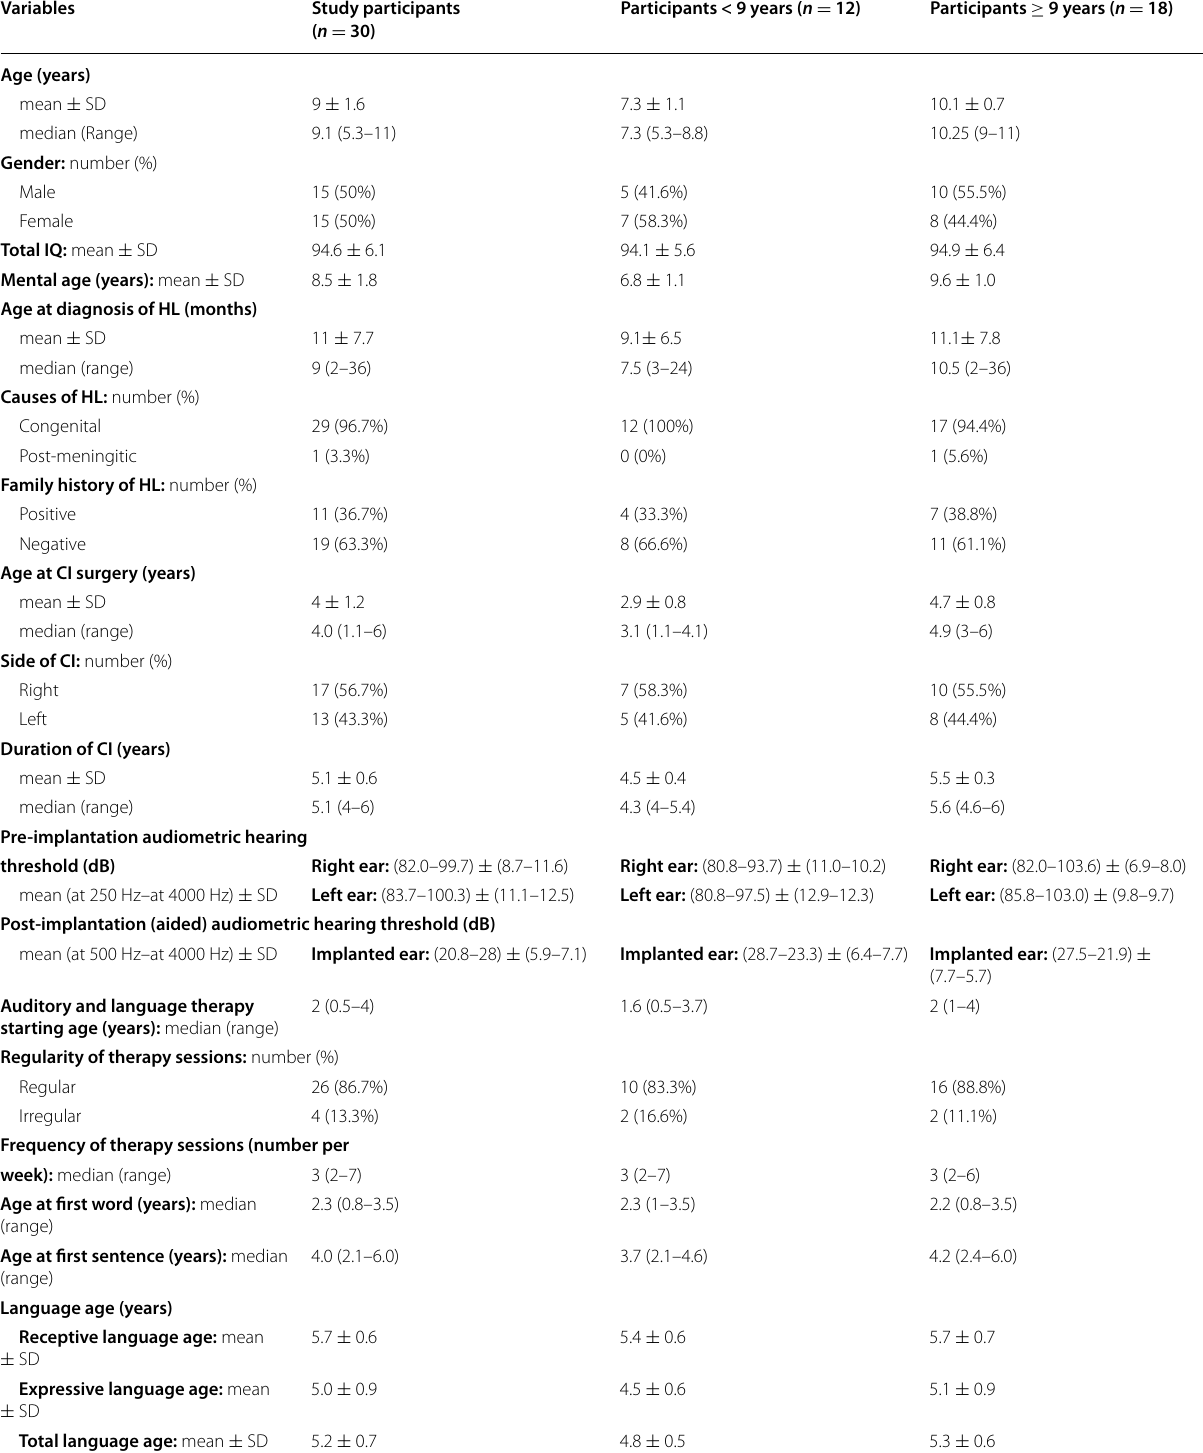
Table 1 Characteristics of the study